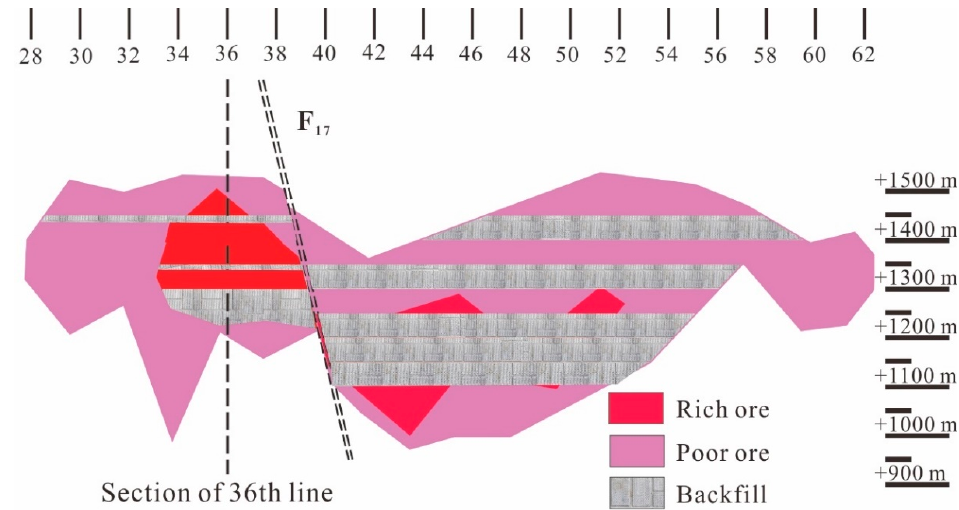
Figure 3. Cutaway schematic drawing of mining area No. 3.